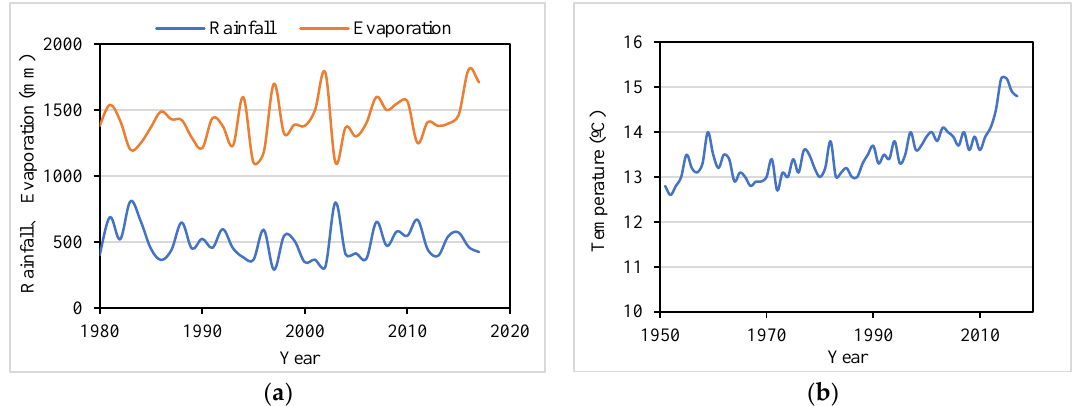
Figure 2. Characteristics of climate change in the study area. ( a ) The annual rainfall and evaporation